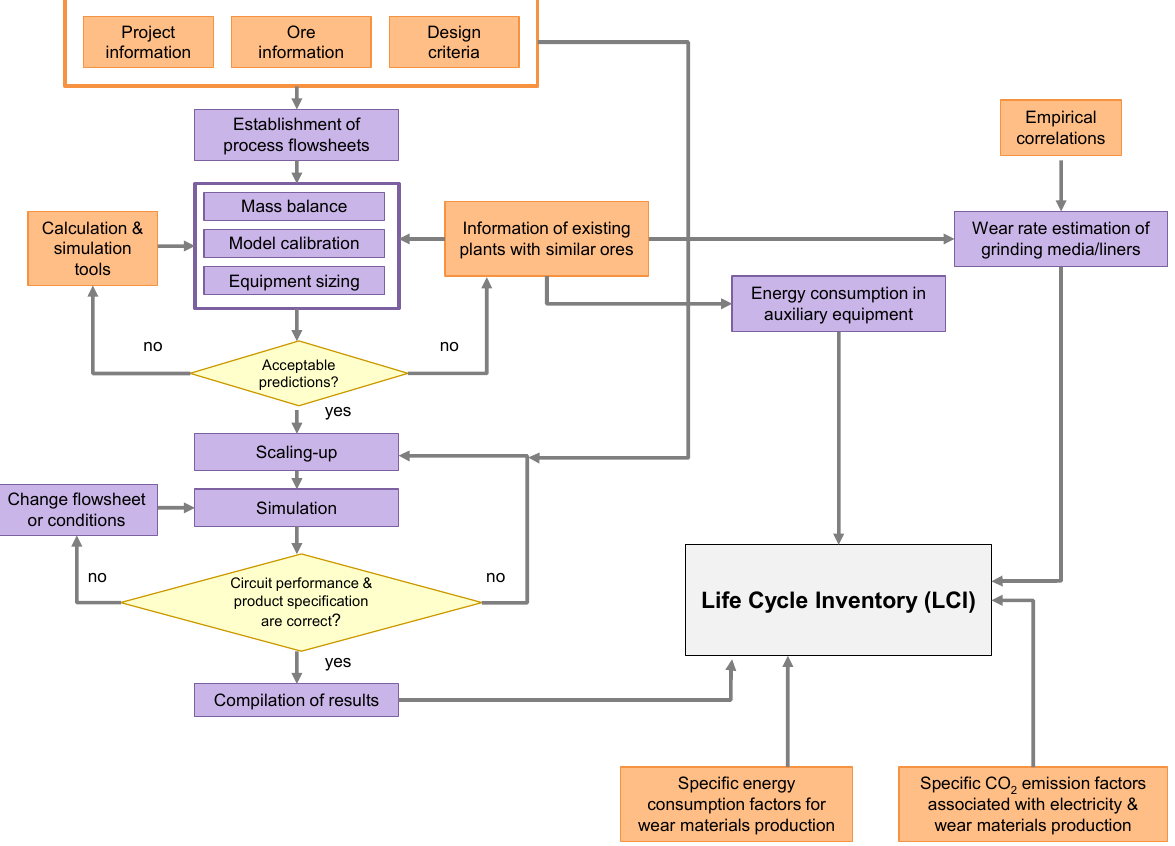
Figure 3. LCA-based approach applied to comminution processes in the design stage of a project.